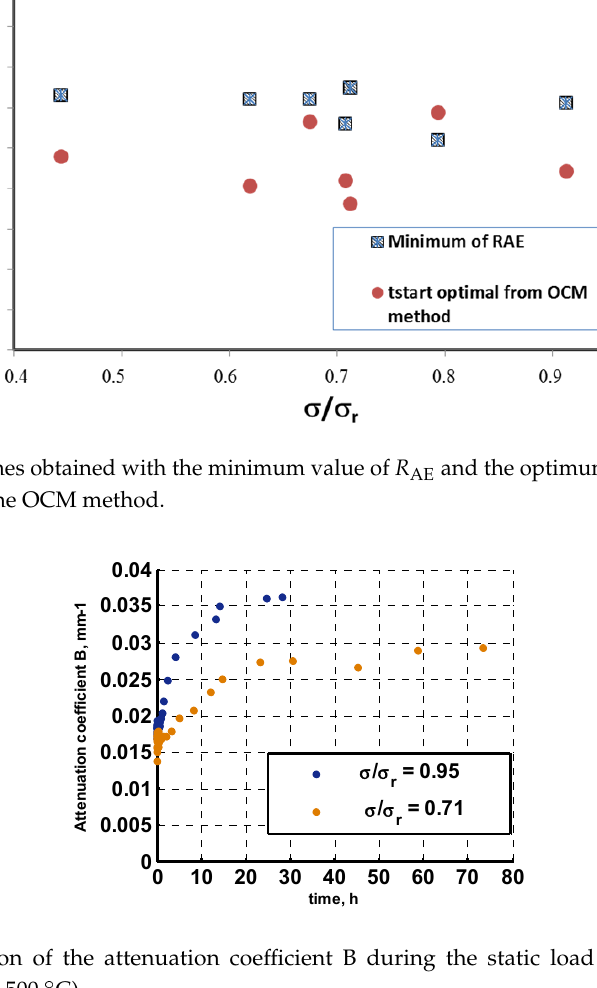
Figure 10. Evolution of the attenuation coefficient B during the static load hold ( σ / σ R = 0.95, σ / σ R = 0.71 and T = 500 °C).